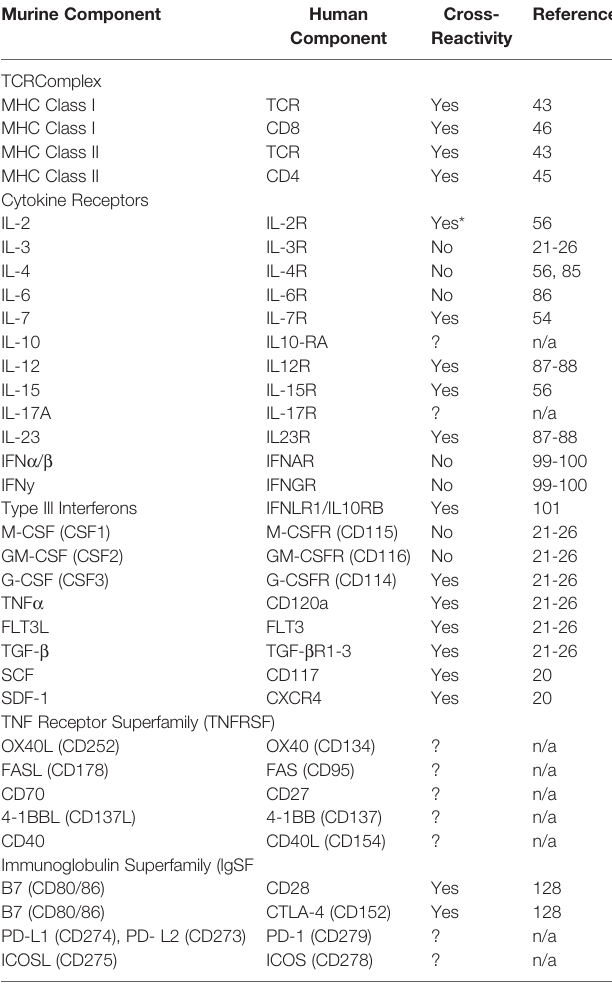
TABLE 1 | List of mouse to human cross-reactive molecules. Murine Component Human